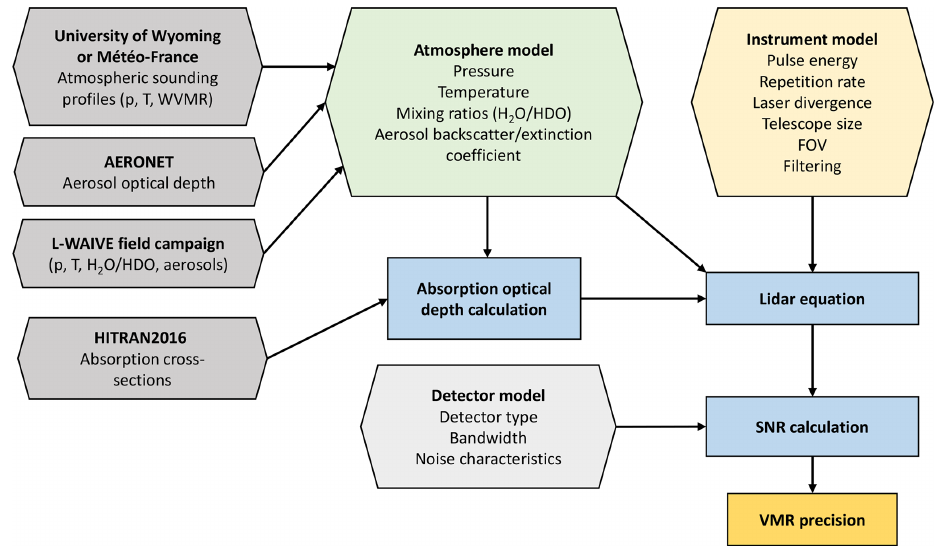
Figure 2. Block diagram of the DIAL simulator. Input models and databases are in hexagons, and principal calculations are indicated by rectangles. p : pressure; T : temperature; WVMR: water vapor mixing ratio; FOV: telescope field of view. The signal-to-noise ratio (SNR) is used to calculate the statistical random error (precision) of the volume mixing ratio (VMR) of H 2 O /